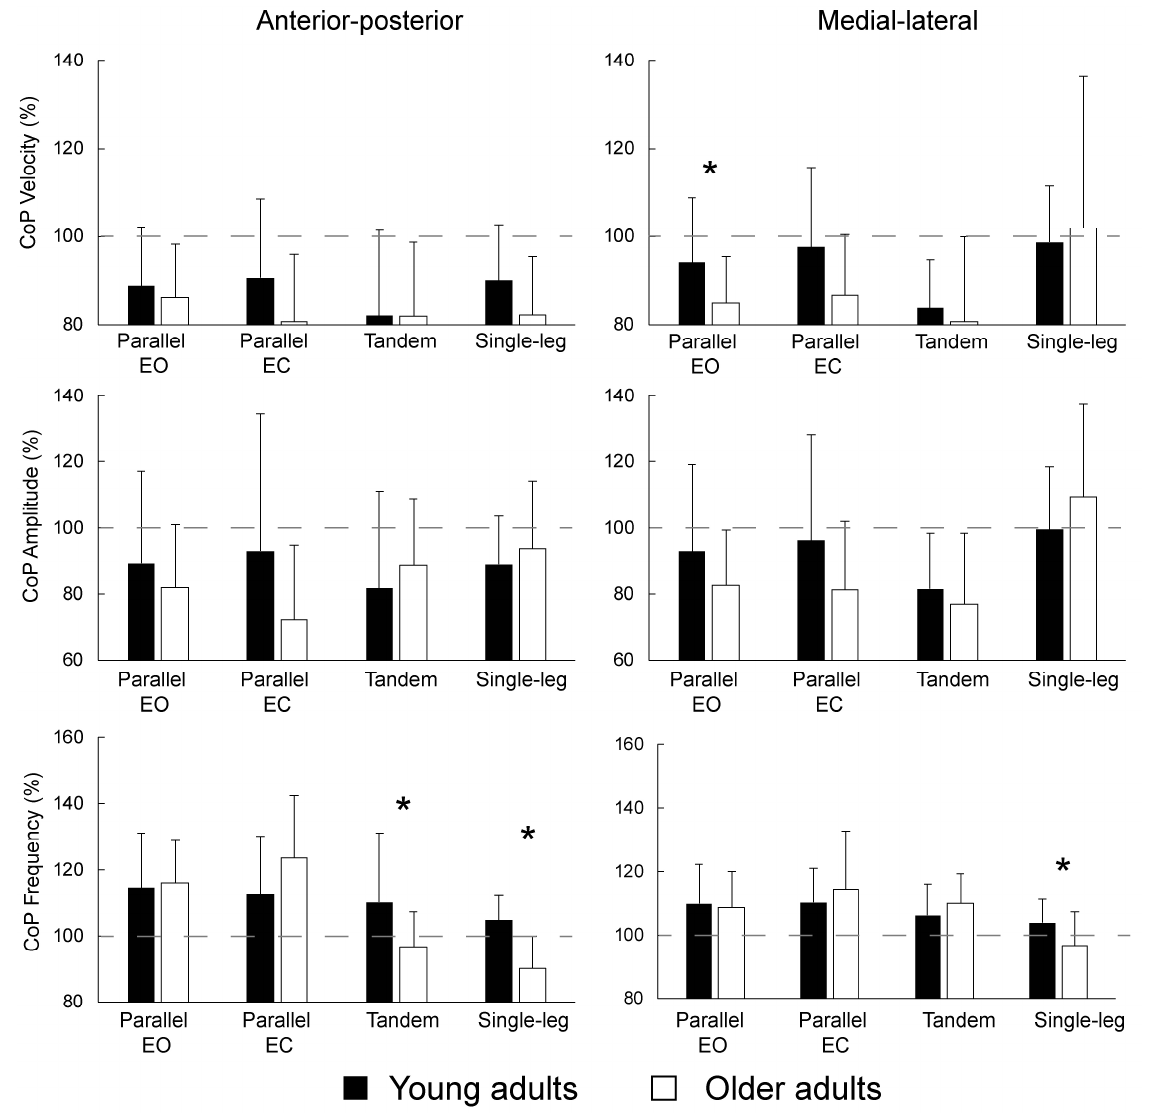
Figure 3. Comparison of the DIF_31 index (relative difference between the 3rd and 1st interval of the trial) between young and older adults across tasks. CoP—center of pressure; AP—anterior–posterior; ML—medial–lateral; EO—eyes open; EC—eyes closed. The dashed line indicated the value corresponding to no transient response (i.e., the same value of postural sway in the 1st and 3rd interval). * Indicates statistically significant difference between the young and older group ( p < 0.05).